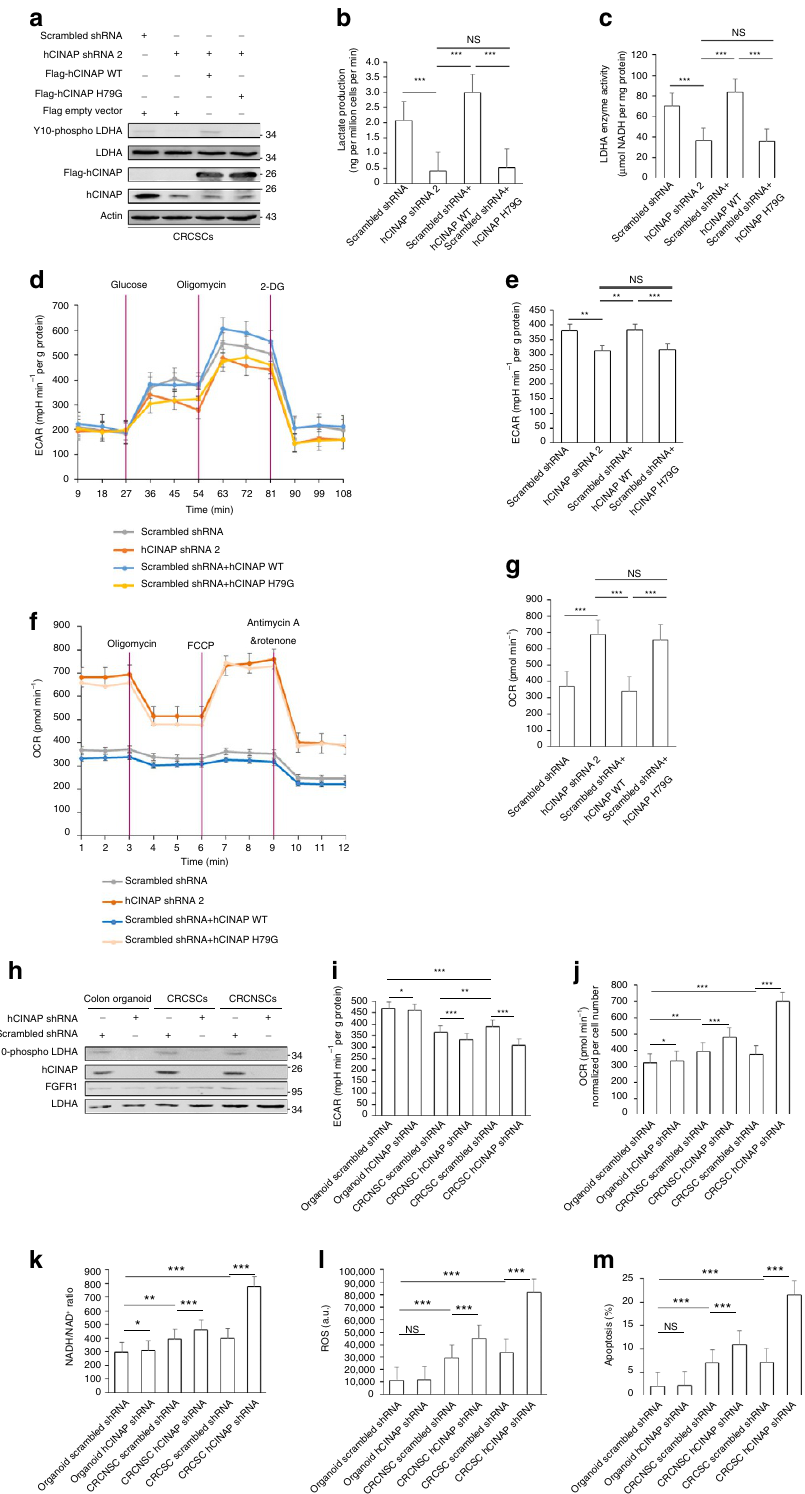
Figure 6 | Adenylate kinase hCINAP promotes the Warburg effect in CRC cells. ( a ) Immunoblot analysis of LDHA Y10 phosphorylation in CRCSC spheres transfected with shRNAs and plasmids as indicated. ( b , c ) Lactate production levels and LDHA enzyme activity were determined in CRCSC spheres as indicated in a . ( d ) ECAR analysis of CRCSCs in a . ( e ) ECAR levels of CRCSCs treated with glucose (10mM). ( f ) OCR analysis of CRCSCs in a . ( g ) OCR (basal respiration) levels of CRCSCs in a . ( h ) Western blot analysis of LDHA Y10 phosphorylation levels in colon organoid, CRCNSCs (CD133-negative CRC cells derived from patient) and CRCSCs (CD133-positive CRC cells) transfected with scrambled shRNA or hCINAP shRNA, respectively. ( i – m ) ECAR, OCR, NAD þ /NADH, ROS and apoptosis levels (quantified from Supplementary Fig. 5c) were measured from cells in h . Data in b , c , e , g , i – m are are determined by Student’s t-test and presented as mean ± s.e.m. ( n ¼ 3). NS, not significant, * P o 0.05, ** P o 0.01, *** P o 0.001. The unit of ROS (a.u.) is short for arbitrary